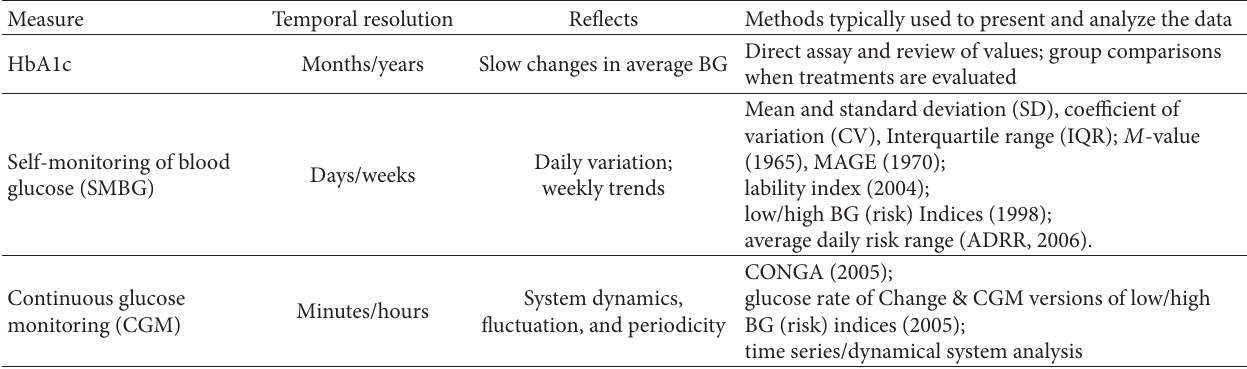
T 1: Frequency of available glucose monitoring technologies. Temporal resolution